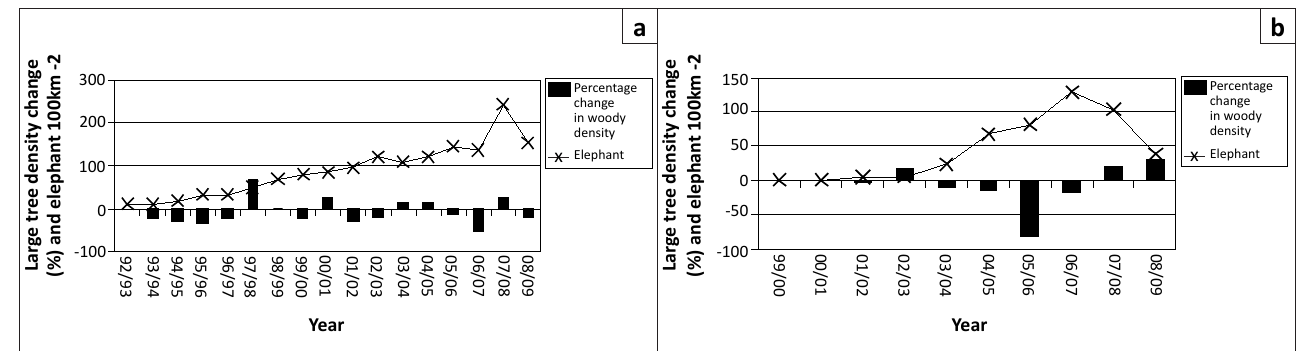
FIGURE 4: The annual percentage change in trees taller than 5 metres (a) compared to an increasing trend in elephant density in one of the private protected areas and (b) compared to a variable trend in elephant density in a private protected area.